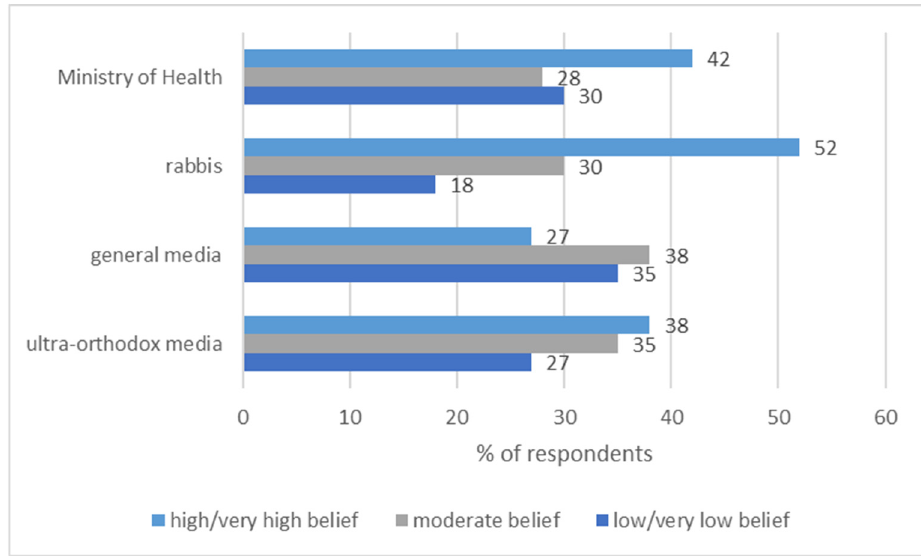
Figure 4. Belief in information according to its primary source by percentage (N =